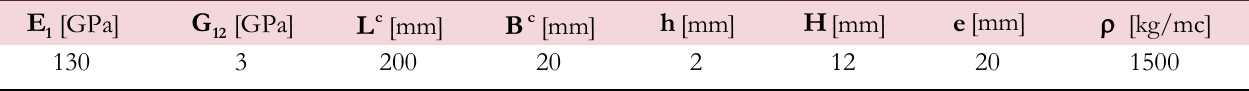
Table 1: Geometrical and mechanical properties of the